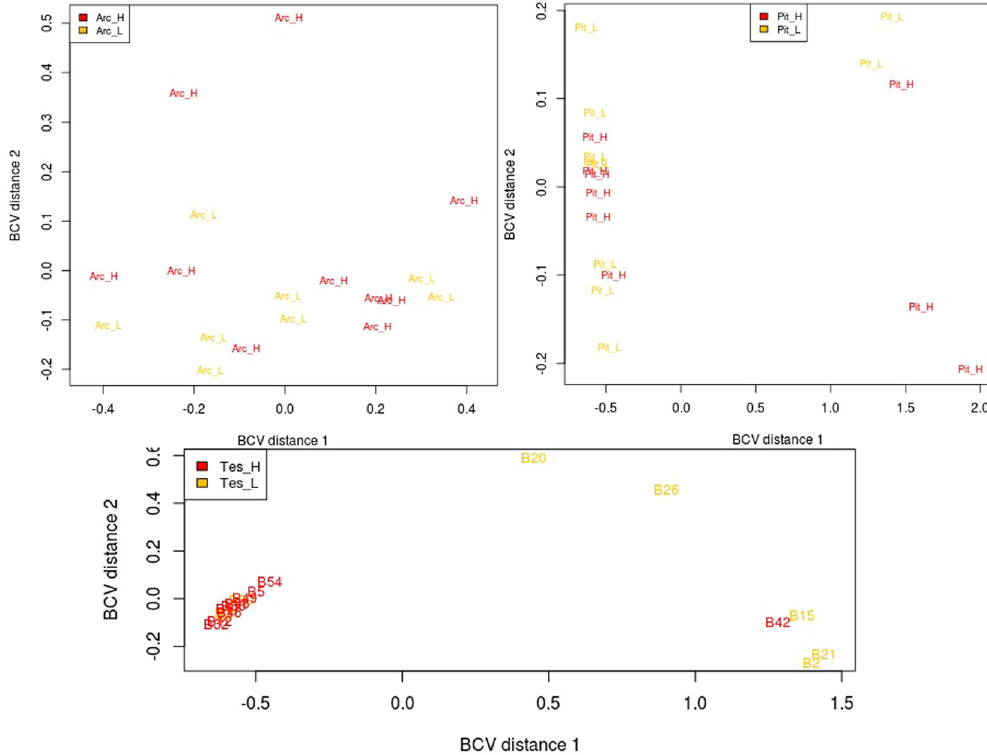
Figure 1. Multidimensional scaling plot which shows the measured similarity of the samples in 2-dimensions. The samples labelled in yellow are the Holstein-Friesian dairy bulls fed on a low plane of nutrition and slaughtered at 18 weeks of age and those labelled in red are the Holstein-Friesian dairy bulls fed on a high plane of nutrition and slaughtered at 18 weeks of age. Arc = Arcuate nucleus, Pit = Anterior Pituitary, Tes = Testes.